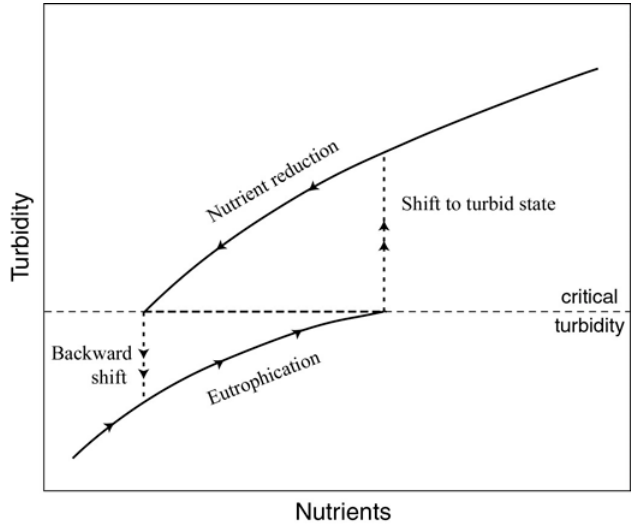
FIGURE 5 . As a consequence of the alternative stable states the lake shows hysteresis in response to changes in nutrient loading. Once the lake has shifted to the turbid state, a reduction of nutrients leads to a relatively moderate decrease in turbidity along the upper branch of the equilibrium graph until nutrient levels have dropped enough to go through a backward